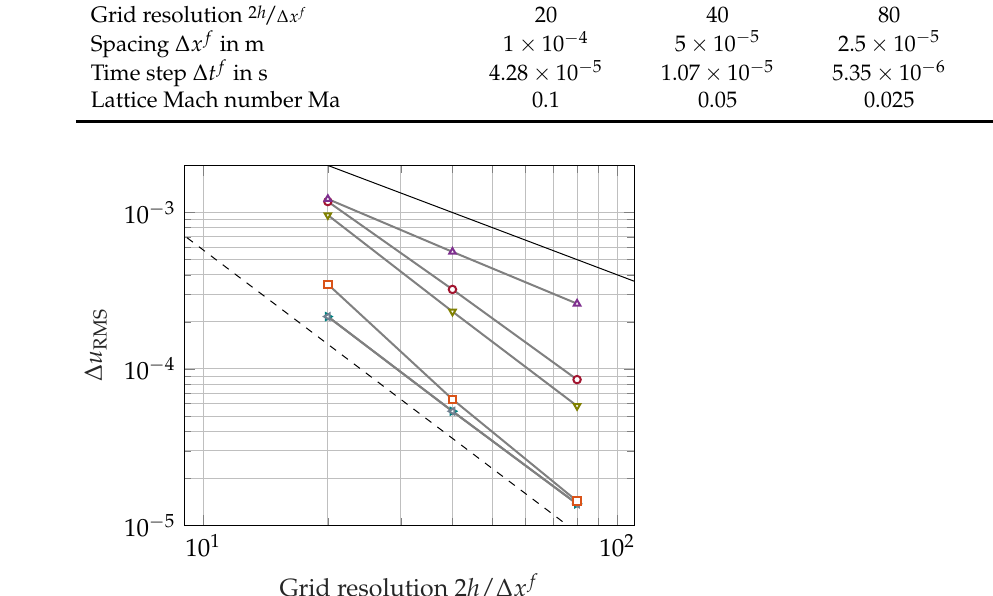
Figure 11. Grid convergence for HRR collision model and all grid layouts with ˜ ω c = 1.94990 (Re h , b = 67.53): Sl-4 ( ), cv-4 ( ), cv-7 ( ), cc-4 ( ), cc-6 ( ), cm-4 ( ), slope -1 ( ), slope -2 (